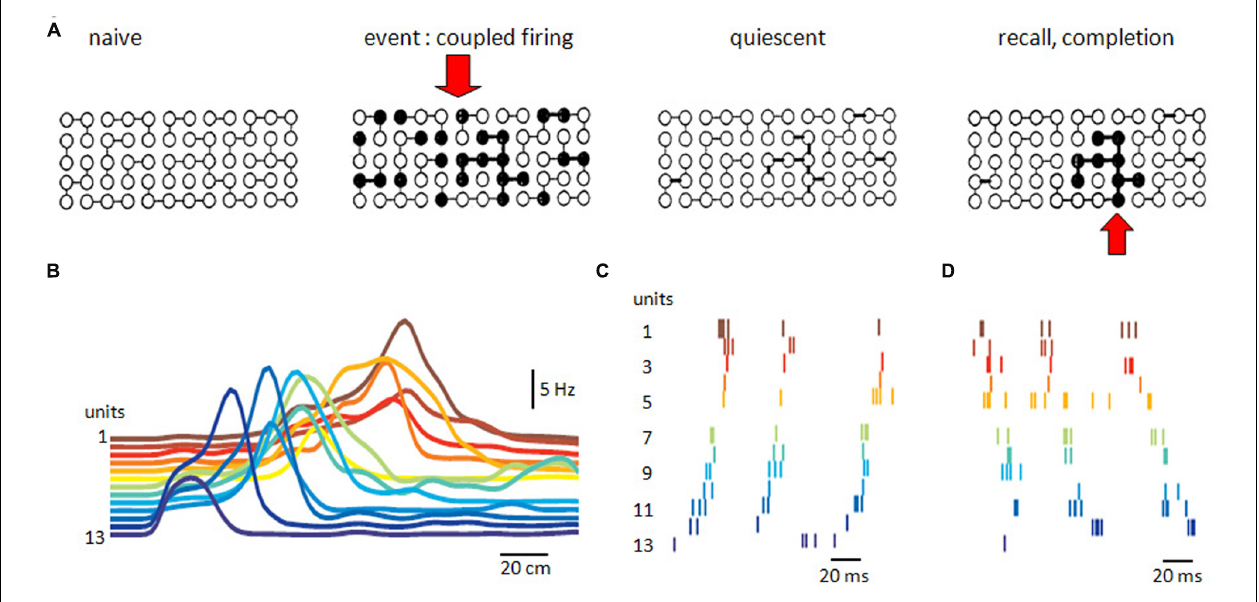
neuronal subset associated with the original event. (B) Sequential firing of 13 pyramidal place cells as an animal passes through a space (horizontal axis is distance). Reactivation of sequential firing of these cells as (C) forward replay or (D) backward replay (adapted with permission from Diba and Buzsáki,